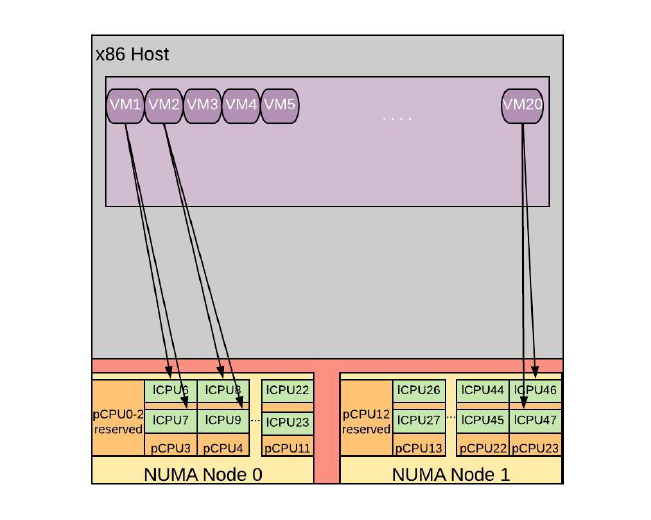
Figure 8. CPU allocation in a 2:1 oversubscribed system.